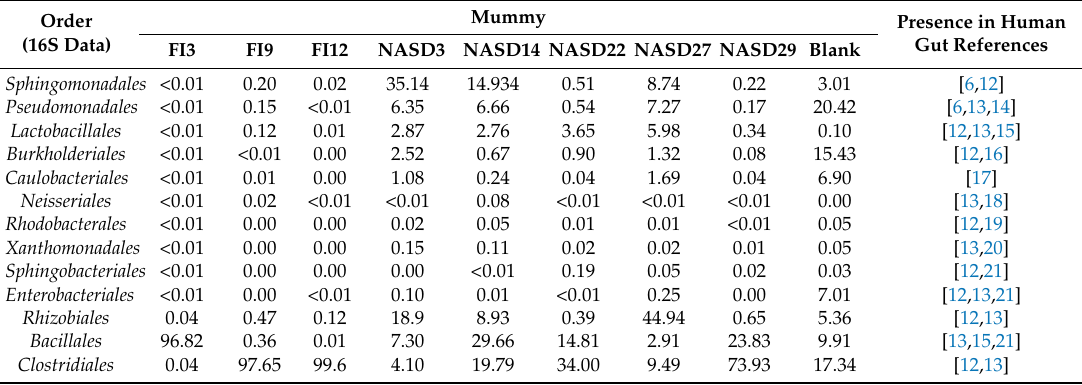
Table 1. Abundances (%) of selected bacterial taxa at the order level in the pre-Inca/Inca (FI3, FI9, and FI12) and Italian nobility mummies (NASD3, NASD14, NASD22, NASD27, and NASD29), and the blank control. The percentages are relative to the total number of reads in each sample. Mummy Presence in Human Order (16S Data) Gut ReferencesFI3 FI9 FI12 NASD3 NASD14 NASD22 NASD27 NASD29 Blank Sphingomonadales